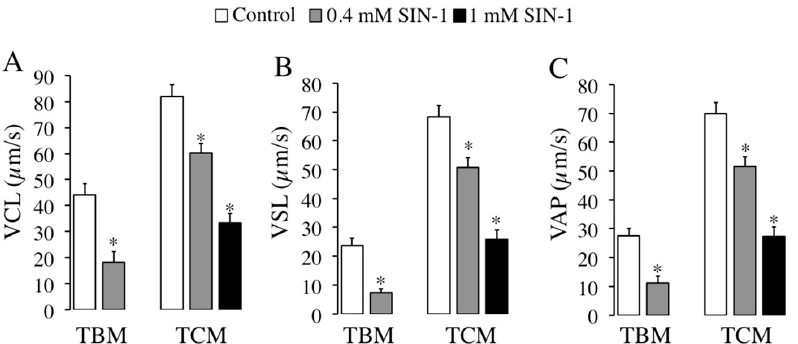
Figure 3. Effects of SIN ‐ 1 induced ‐ peroxynitrite in boar spermatozoa velocities. Boar spermatozoa were incubated in TBM or TCM at 38.5 °C in the absence (white histograms) or presence of indicated concentrations of SIN ‐ 1 (filled histograms) for 1 h. Boar sperm velocities were evaluated by ISAS ® system: curvilinear velocity VCL ( A ), straight ‐ linear velocity VSL ( B ), and average velocity VAP (C) expressed as μ m/s are shown. This experiment was performed 8 times ( n = 8) and results are expressed as the mean of the percentage of total sperm ± SEM. Statistical differences are shown with * ( p < 0.05). This significant effect is detected at 0.4 mM in both media and the highest reductions in sperm velocity are achieved in TBM with 0.4 mM of SIN ‐ 1 for VSL (70% reduction) and in TCM with 1 mM for VSL (60% reduction). Moreover, SIN ‐ 1 significantly affects others spermatozoa motility coefficients analysed in Table 1. When spermatozoa are incubated with SIN ‐ 1 in TBM, the coefficients of straightness (STR) and the beat cross frequency (BCF) are significantly reduced, whereas in TCM, the amplitude of lateral sperm head displacement (ALH) is significantly reduced. Table 1. Effects of SIN ‐ 1 induced ‐ peroxynitrite in boar spermatozoa motility coefficients.